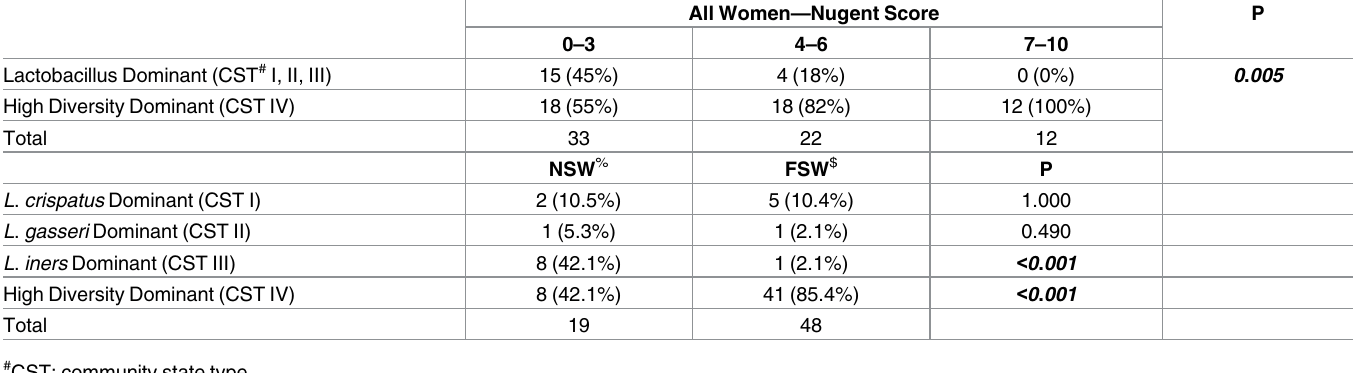
Table 2. Proportion of women with Lactobacillus dominant or highly diverse vaginal microbiota (by Nugent Score) and proportion of women in each community state type (by